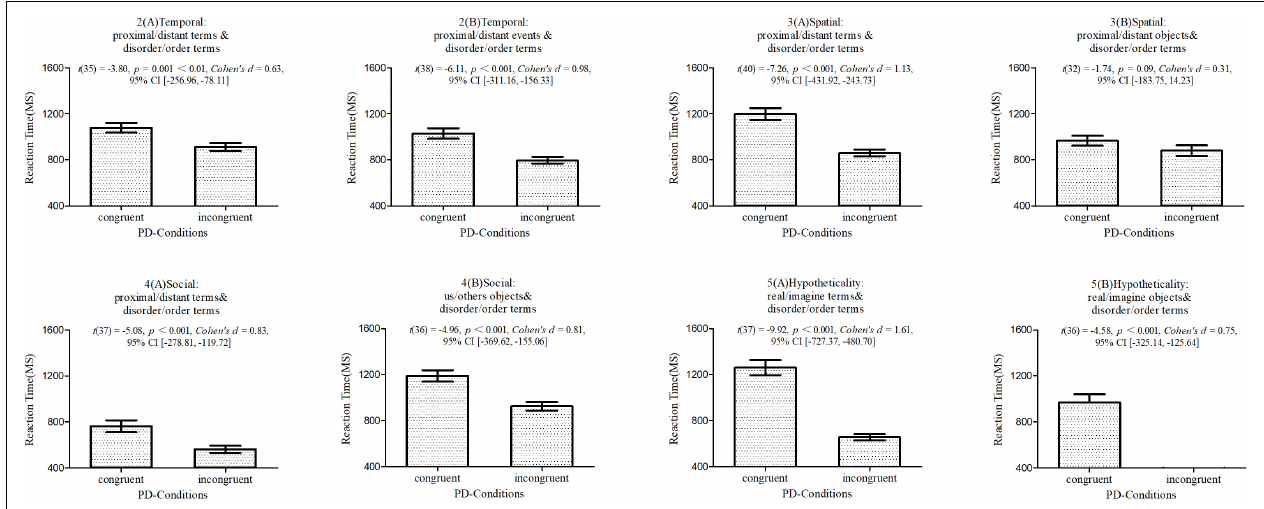
FIGURE 3 | Response times for congruent and incongruent orderliness-distance pairings for studies 2A–5B. The differences between the conditions were significant in all experiments. Error bars represent 2 SEM.